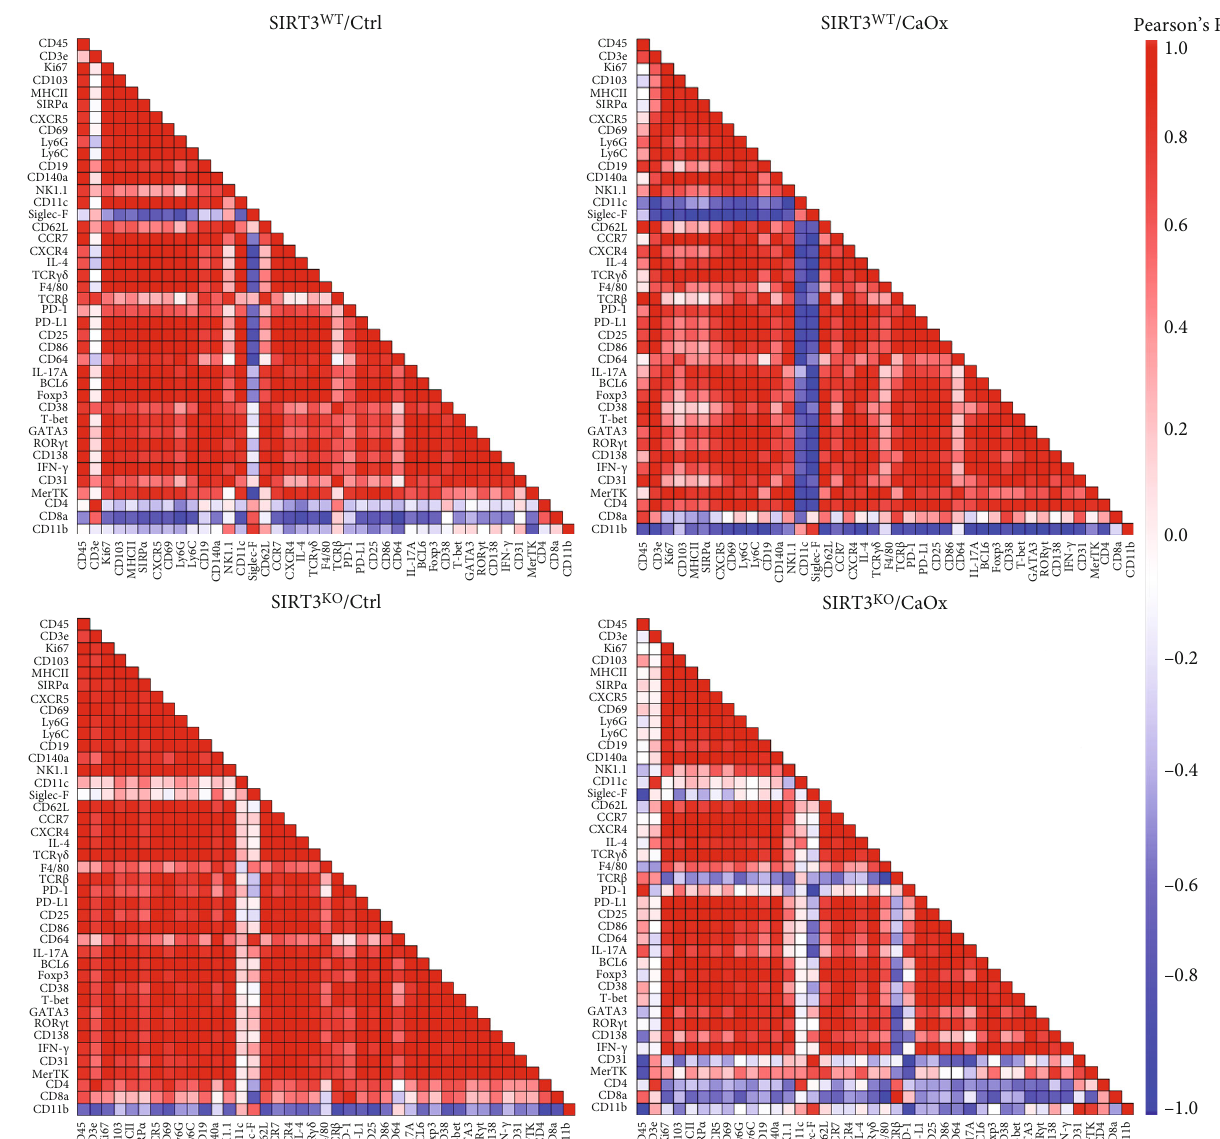
Figure 4: Heatmaps showing Pearson coe ffi cients of correlation for relationships between expressed markers in four di ff erent models with SIRT3 wild-type or knockout and CaOx inducement or